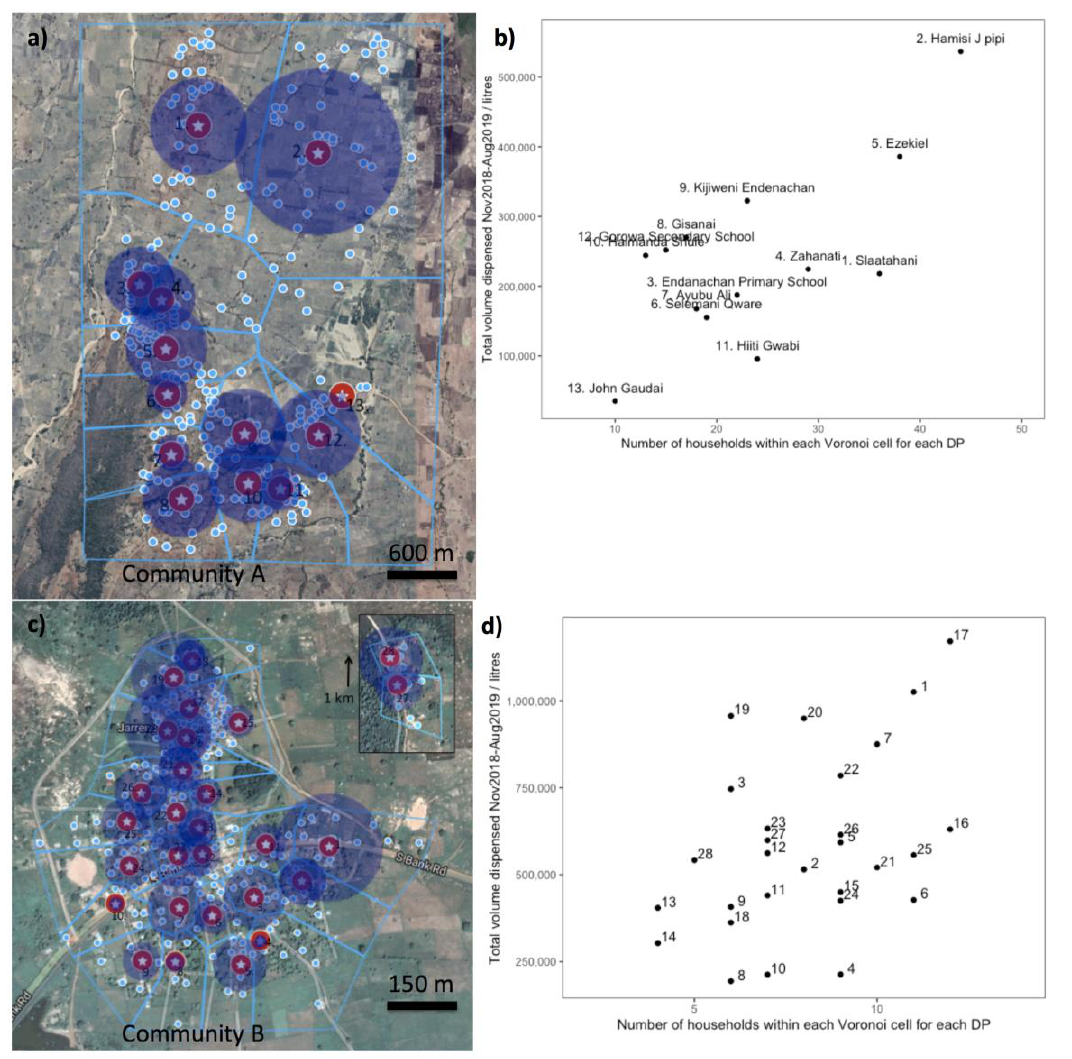
Figure 5. ( a ) DPs (red) and location of all households in Community A (blue dots) with total volumes dispensed over November 2018–August 2019 as radius of disc (blue) showing Voronoi cells for each DP. ( b ) Number of households in Community A that are nearest to each DP against total volume dispensed over November 2018–August 2019. ( c , d ). Community B, as above.